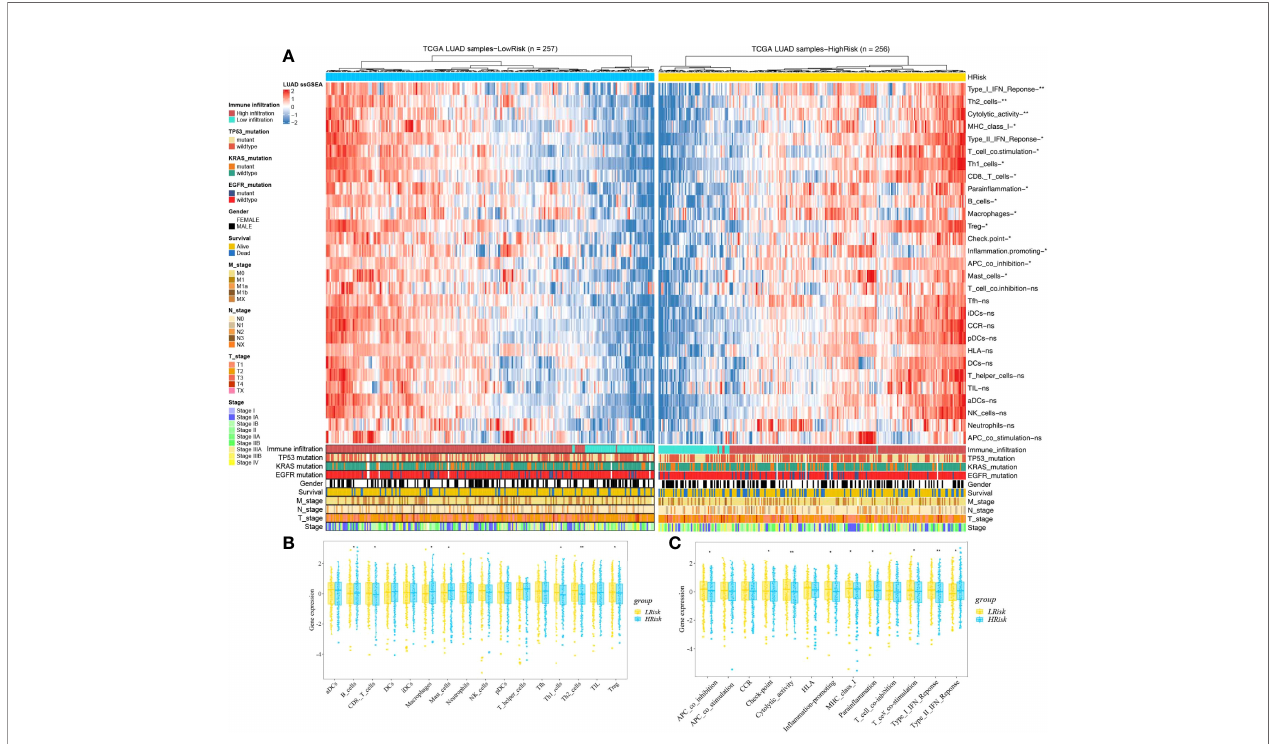
FIGURE 10 | Landscape of immune cell in fi ltrations in the low and high TME risk groups. (A) The heatmap shows the normalized scores of immune cell in fi ltrations. Blue represents cells with lower in fi ltration, and red represents cells with higher in fi ltration. (B, C) The statistical difference between the two groups was compared by the Wilcoxon test. * p < 0.05; ** p < 0.01; ns, not signi fi cant. In the lower panel, mutation status of TP53, KRAS, and EGFR; gender, survival; TNM stage; and stage were